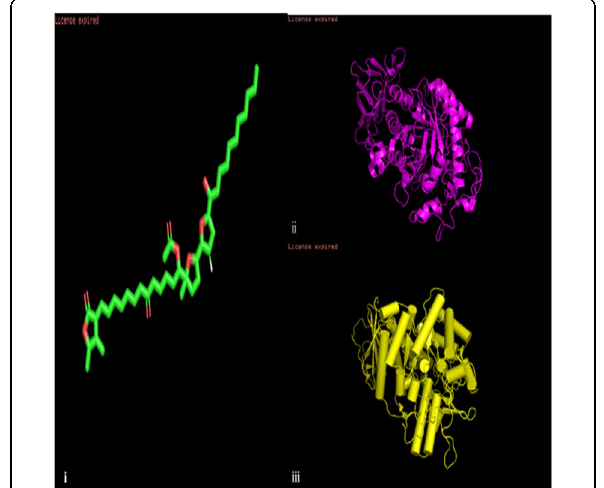
Fig. 15 2D structure of 15-acetyl guanacone (i), the 3D structure of α -amylase (ii), and 3D structure of α -glucosidase